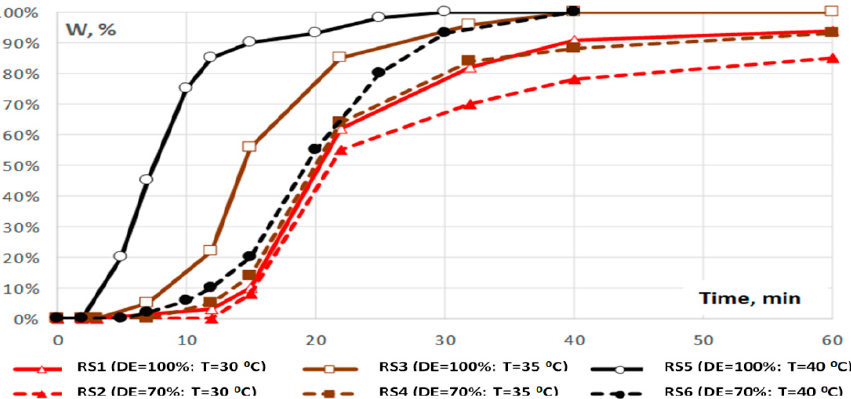
Figure 6. Kinetics of water fallout at different inlet temperatures and different levels of demulsifier input (W/O = 67%).